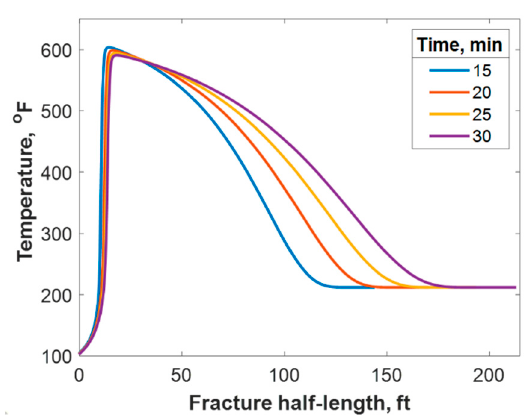
Figure 10. Temperature profile along the fracture half-length at different injection times.